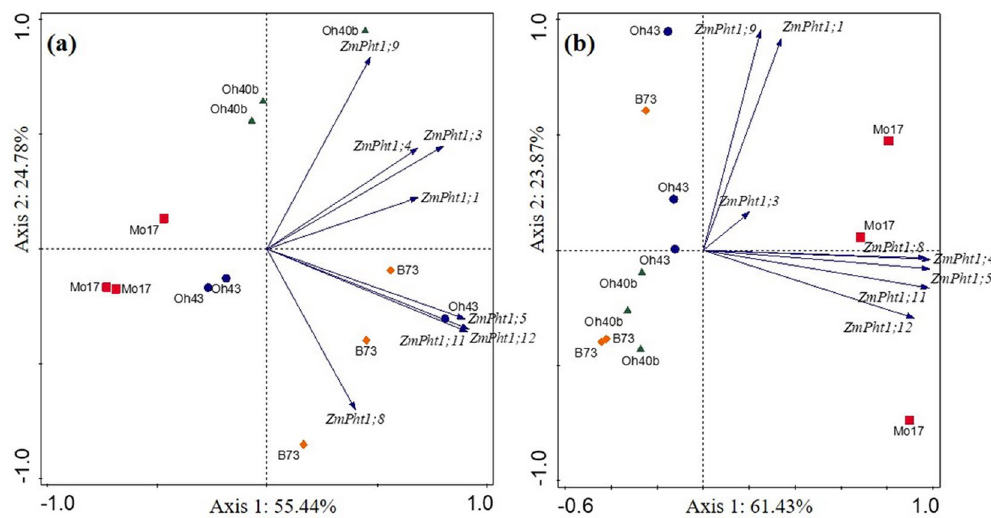
Figure 3. Principal Component Analysis (PCA) biplots of the normalized expression level of P transporters ( ZmPht1 ) expressed in roots at low phosphorus availability (0.47 mg kg −1 ) by four inbred lines of Zea mays either uninoculated ( a ) or in symbiosis with Rhizoglomus irregulare ( b ). In ( a ), the first and second axes explain 80.22% of total variance; in ( b ), the first and second axes explain 85.30% of total variance.